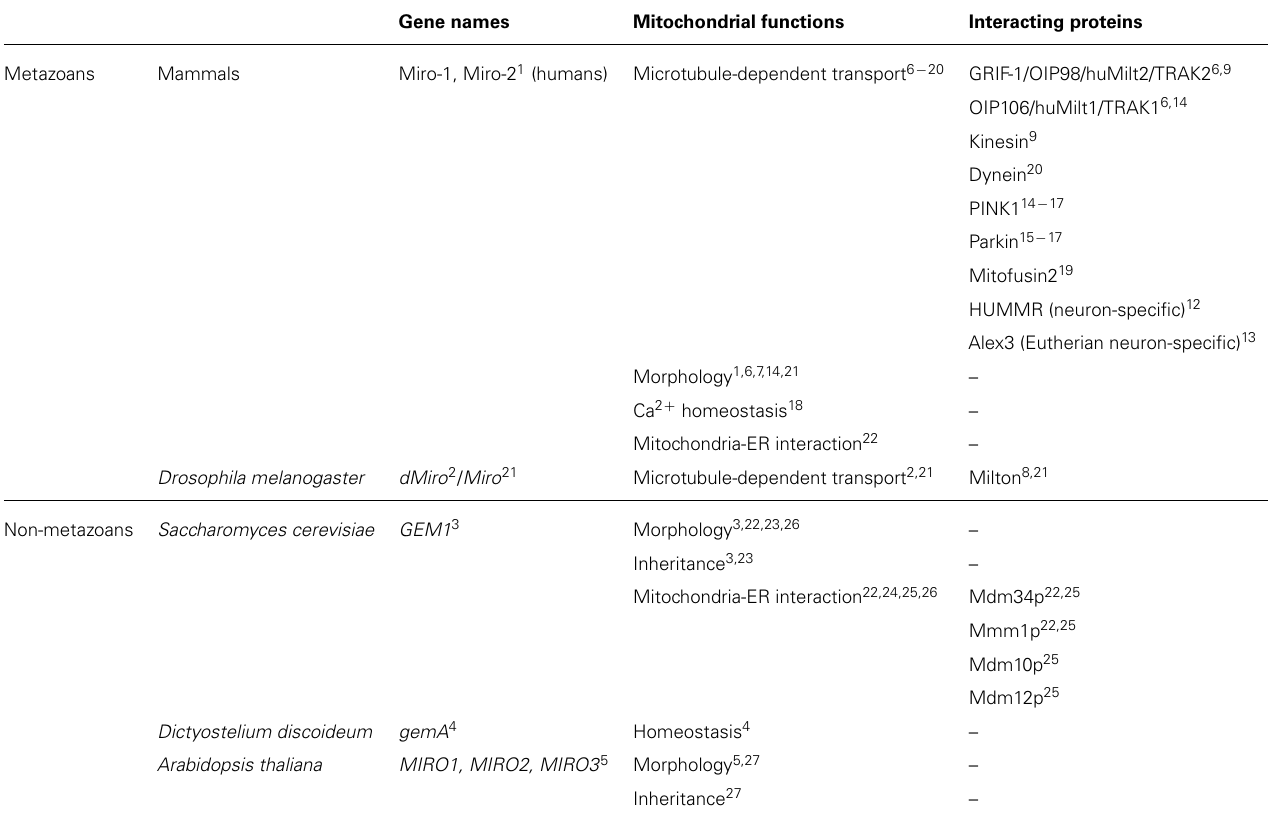
Table 1 | Molecular function and interacting proteins of Miro GTPase from various